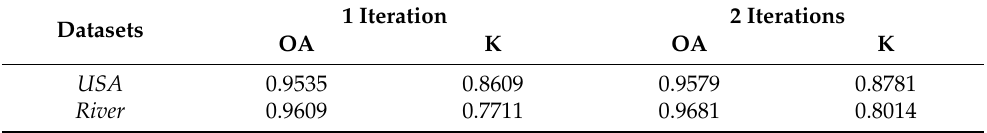
Table 2. Output of the Gaussian Naive